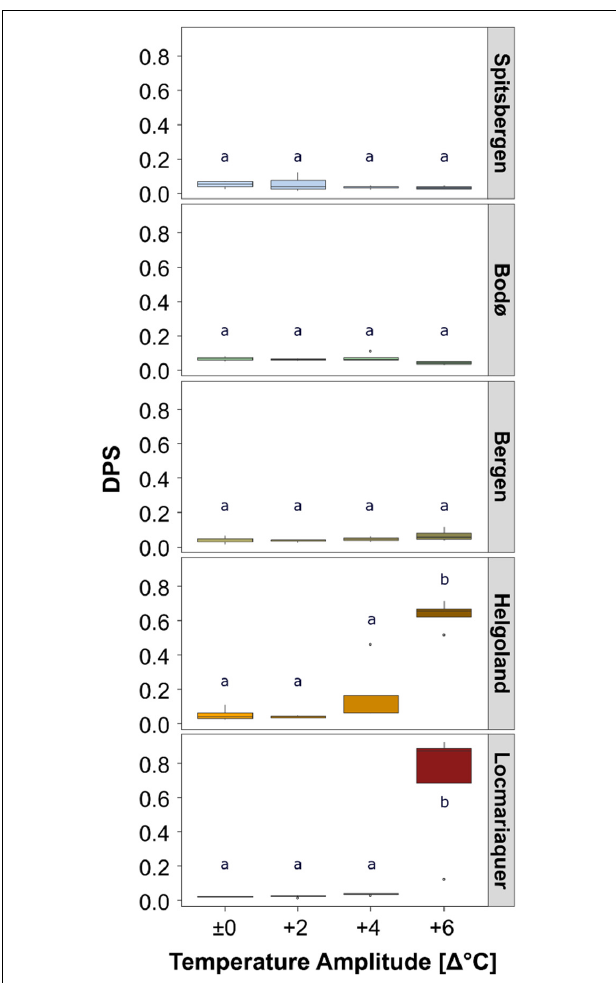
FIGURE 5 | De-epoxidation state of the xanthophyll cyle (DPS) of Saccharina latissima across latitudes in Europe after the temperature-amplitude experiment. Experimental set-up: mean summer SST (control, (cid:49) ± 0 ◦ C) and temperature stress treatments: (cid:49) +2, (cid:49) +4, (cid:49) +6 ◦ C ( n = 4). The bottom line of the box represents the 25th percentile, the center line of the box the median and the top line of the box the 75th percentile. The lower and upper whiskers represent the lowest and the highest values in the data. Significant differences are marked by different